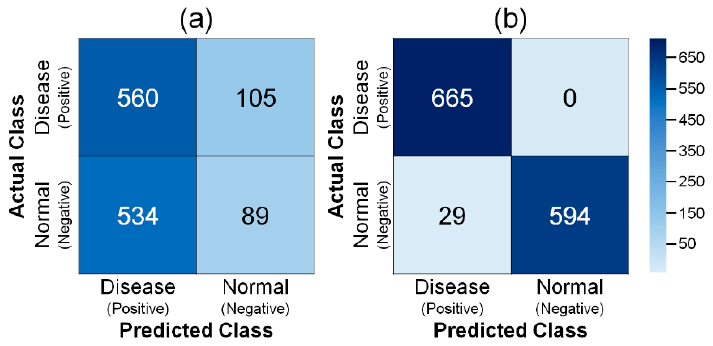
Figure 4. Confusion matrices of two DNNs: ( a ) DNN RN152 , ( b ) DNN MRCNN